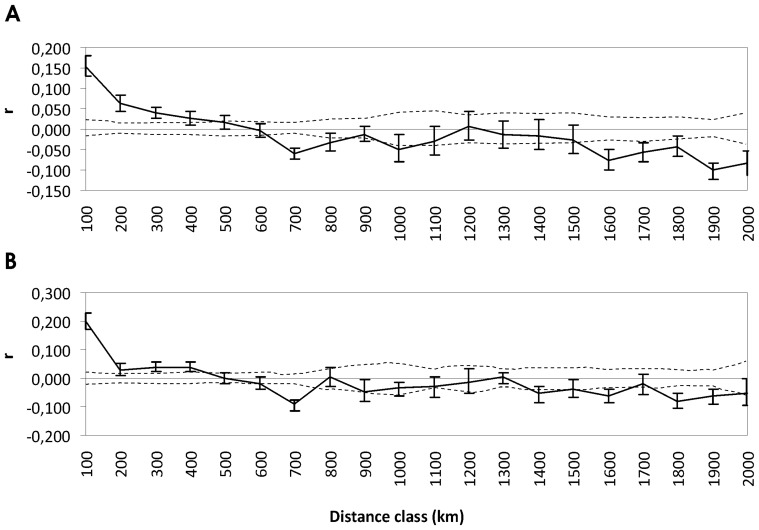
Results of the spatial autocorrelation analysis.Correlograms of the average autocorrelation coefficient (r) for 20 distance classes of 100 km each for male (A) and female (B) Eurasian lynx. The dashed lines represent the 95% upper and lower bounds of the null distribution assuming no spatial structure. The error bars represent the 95% confidence intervals about r. Significant spatial structure is observed when r exceeds the null distribution and the error bars do not overlap zero.